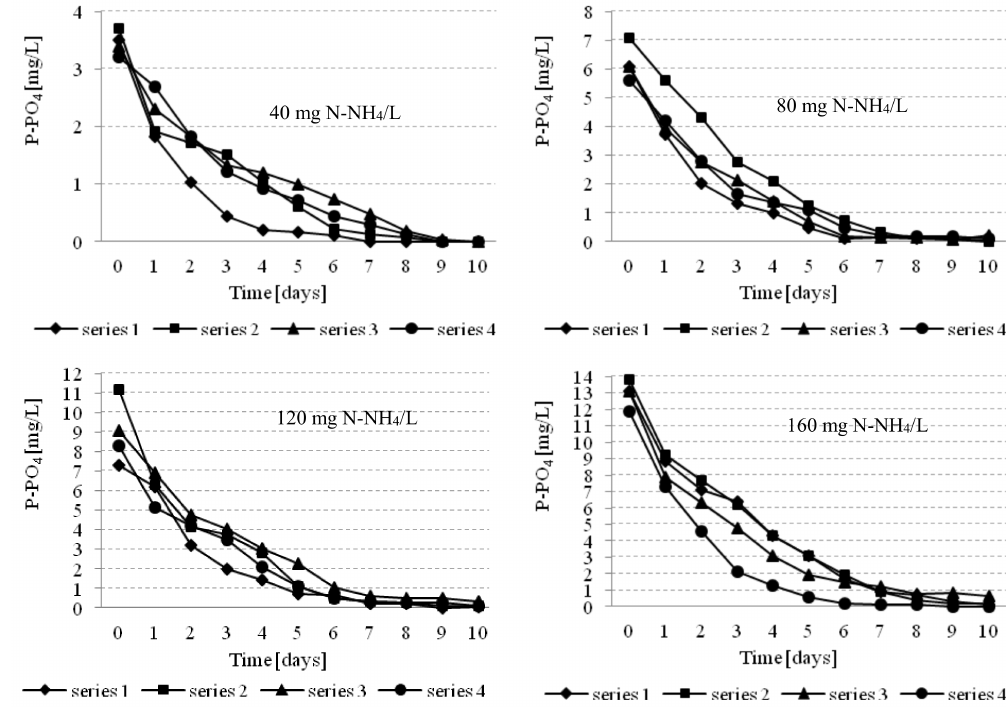
Figure 3. Changes in orthophosphate concentration in experimental variants during the experimental